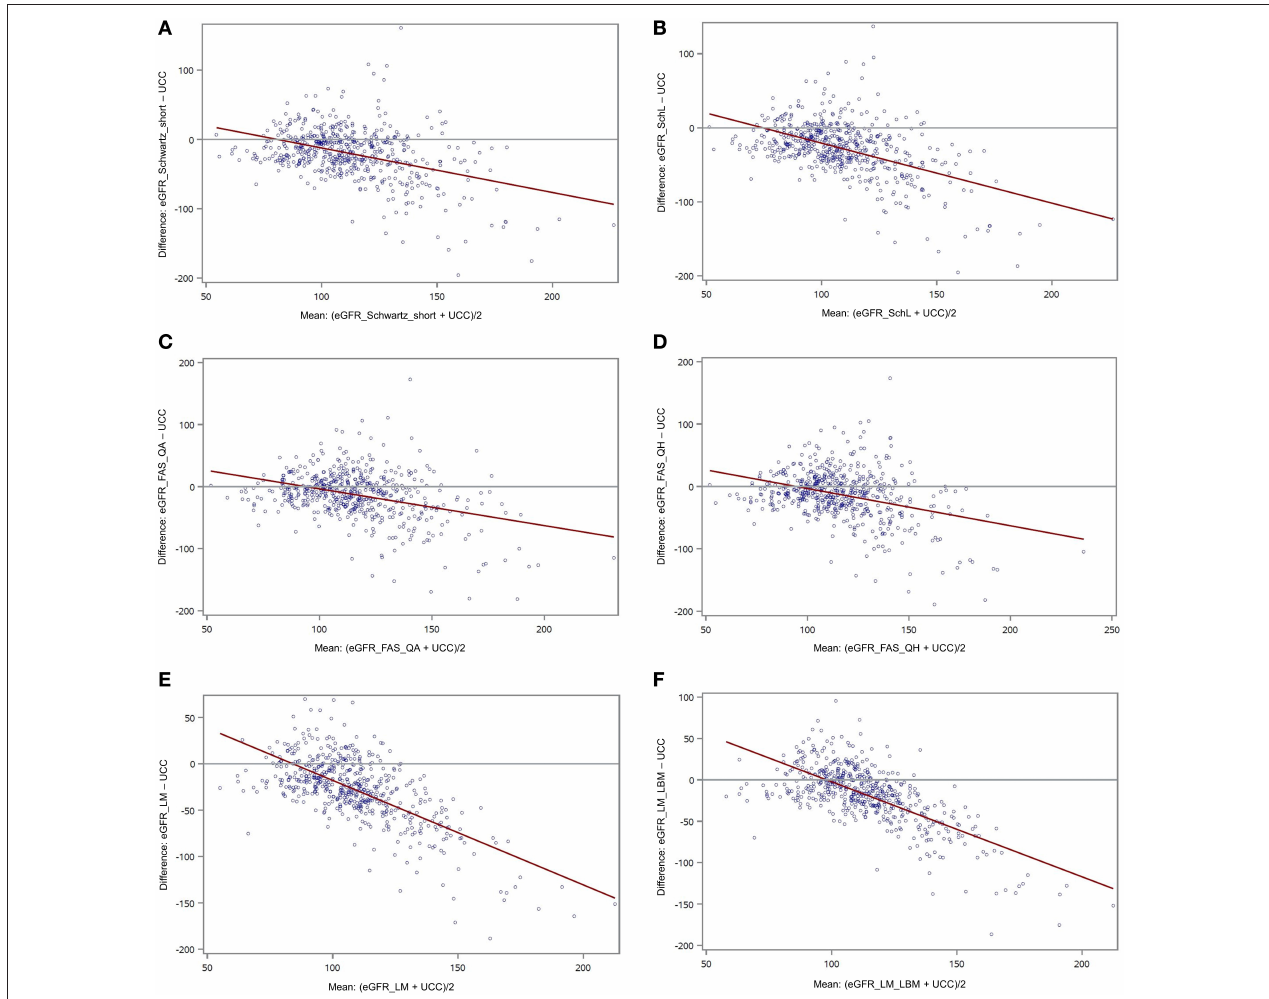
FIGURE 2 | (A–F) Bland-Altman-Plots (plot of differences) between eGFR ( A : eGFR_Schwartz_Short; B : eGFR_Schw_L; C : eGFR_FAS_QA; D : eGFR_FAS_QH; E : eGFR_LM; F : eGFR_LM_LBM) and UCC with red regression line.